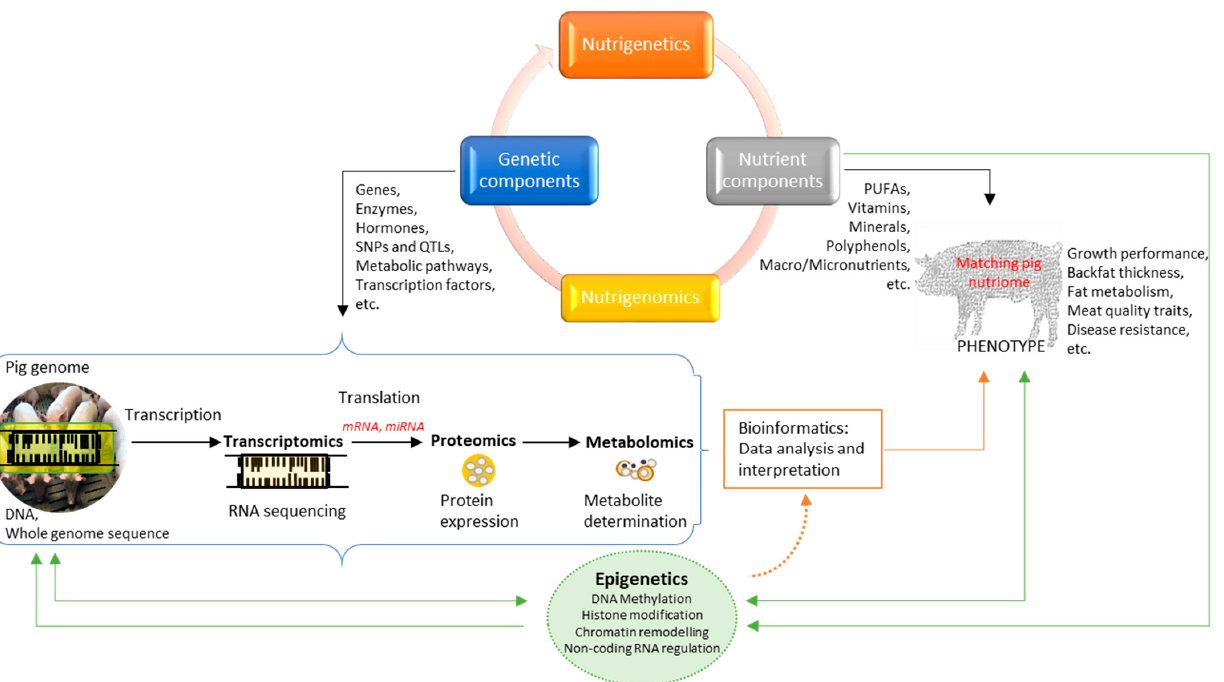
Figure 4. The schematic workflow chart in nutrigenetics, nutrigenomics, and epigenetics science.